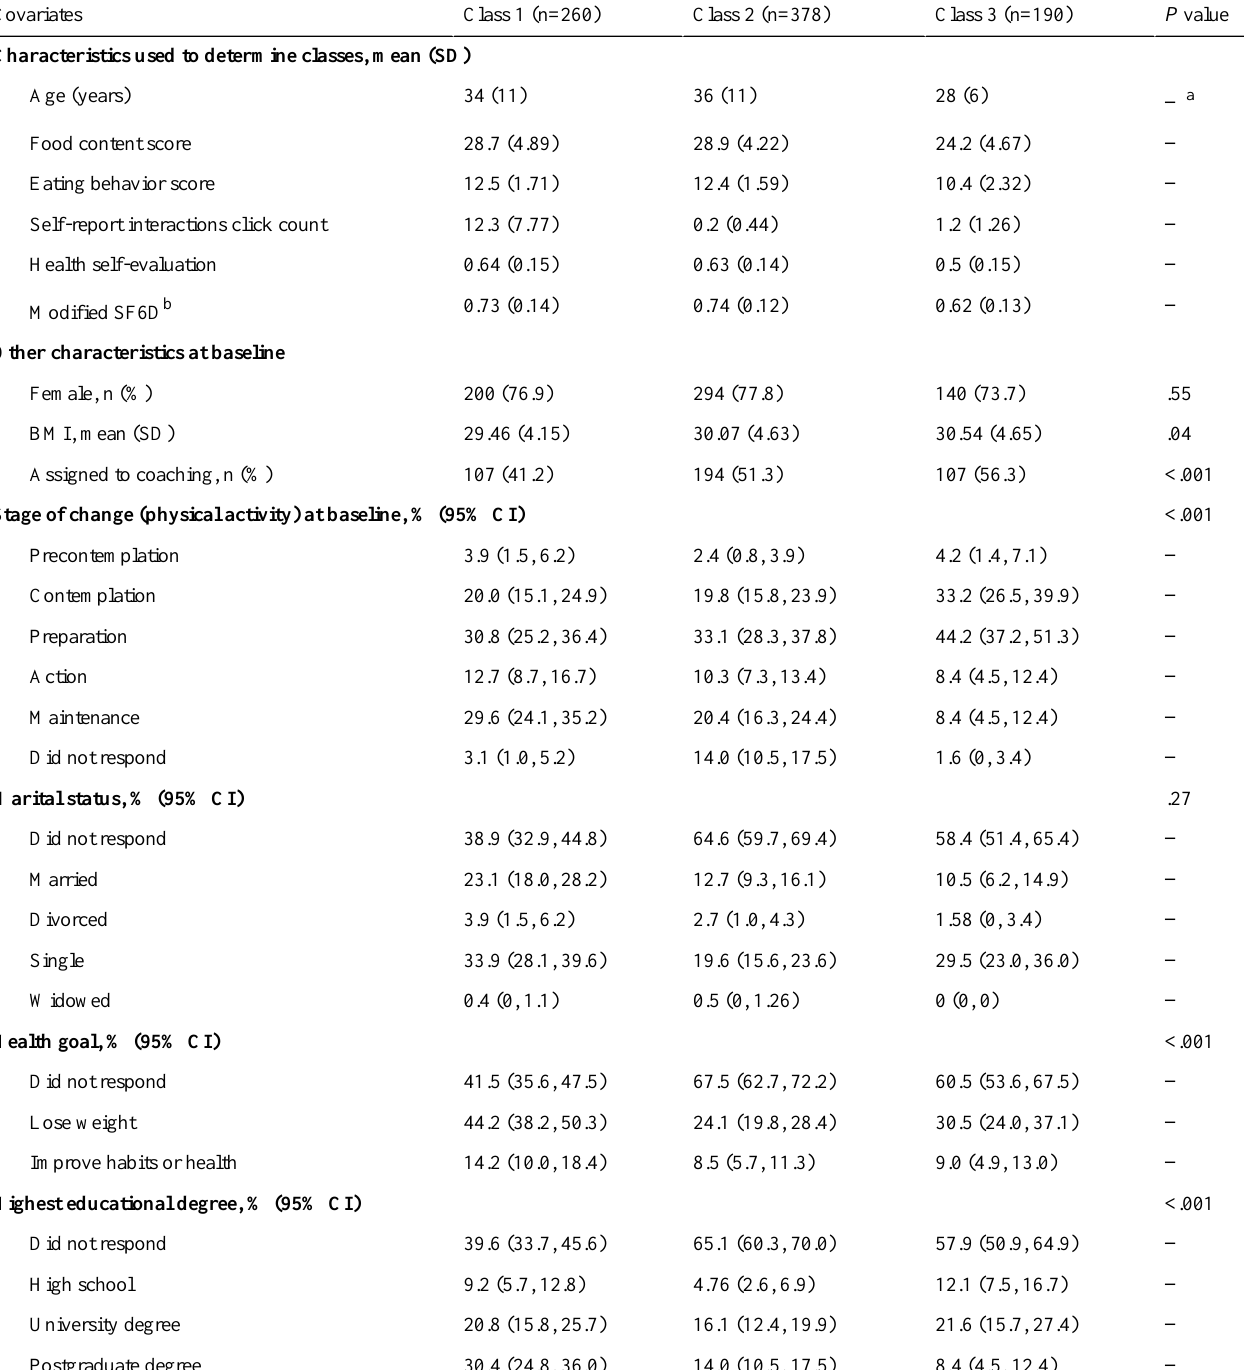
Table 3. Characteristics of users according to latent profile